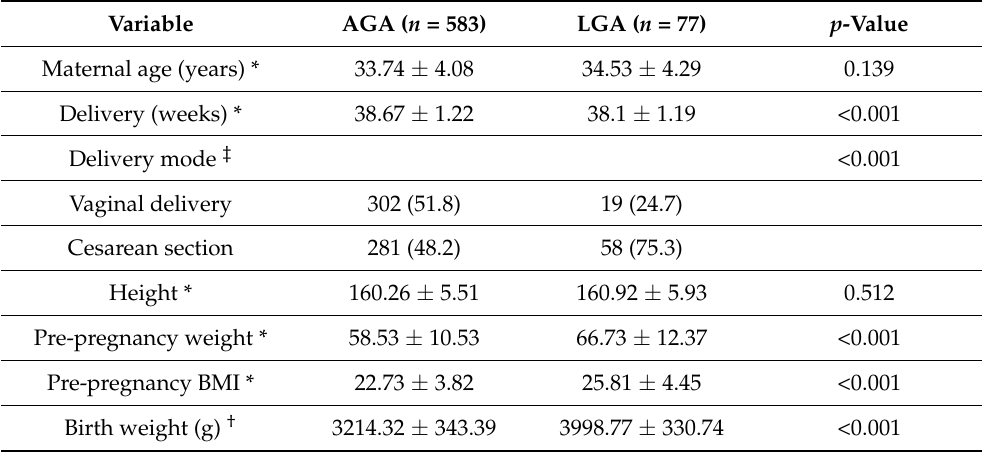
Table 1. Demographic data of pregnant women with gestational diabetes mellitus based on type of infant